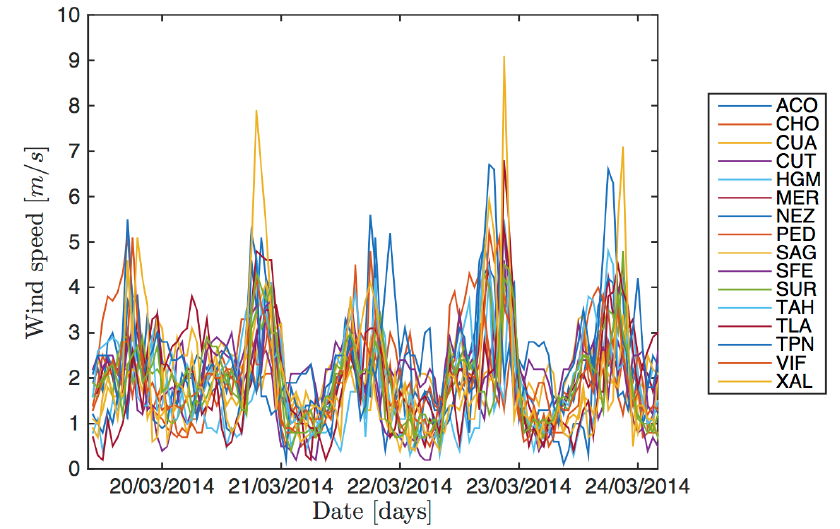
Figure 3. As the first element of analysis, the time series of the locations studied are plotted. Similar behavior is observed over time in all locations, and the maximum and minimum values may be associated with day and night